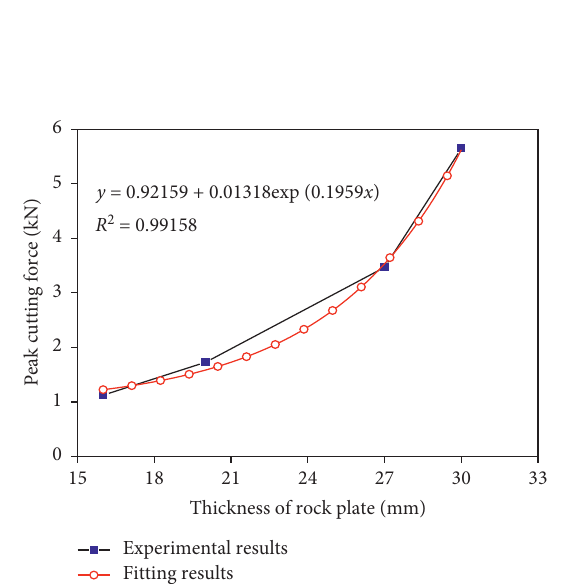
Figure 16: The relationship between PCF and thickness of rock